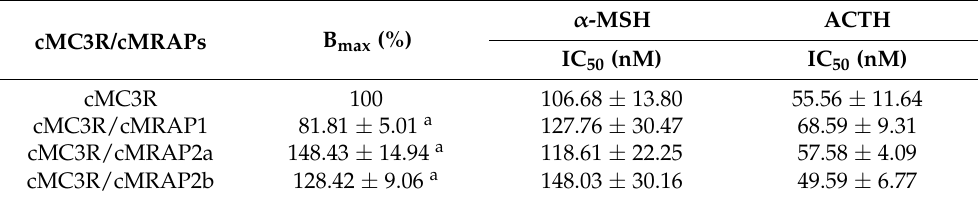
Table 3. The effect of MRAPs on ligand binding properties of cMC3R.